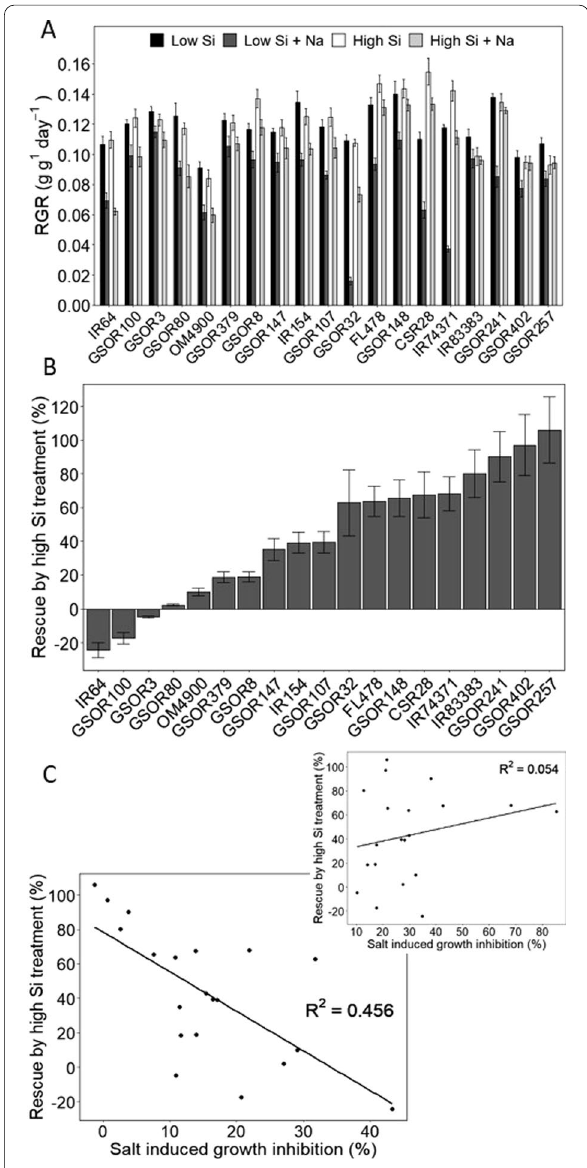
Fig. 1 a Response of different rice cultivars to salinity and Si. Plants were grown in hydroponics for 30 d at low (0.07 mM) and high (1 mM) ambient Si, with (50 mM NaCl) or without (0 mM NaCl) salt stress. Data show means (N 3–5) with standard deviations. = b Increasing external Si concentration reduces the growth loss caused by salinity. When external Si was raised from 0.07 to 1 mM an overall reduction in growth loss was determined. However,